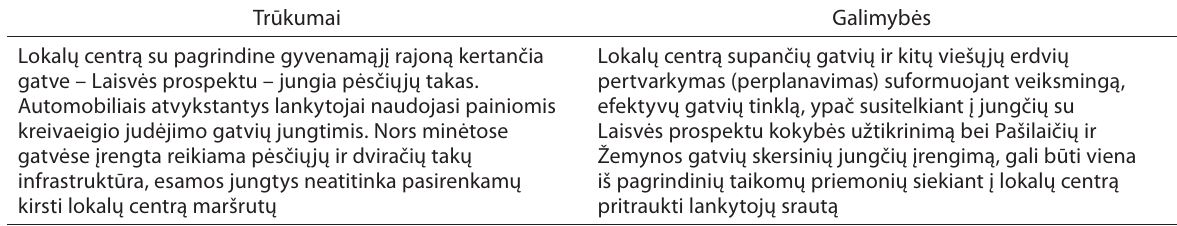
Table 4. Weaknesses and opportunities of the formation of street network in the local centre of Pašilaičiai Trūkumai